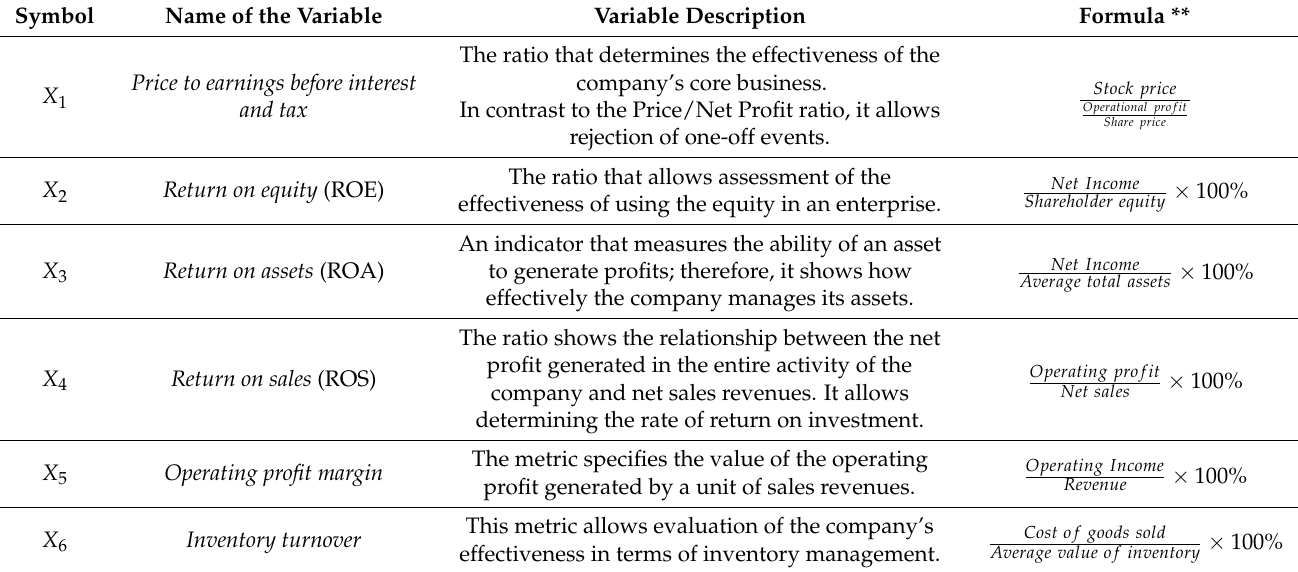
Table 2. Initial set of diagnostic